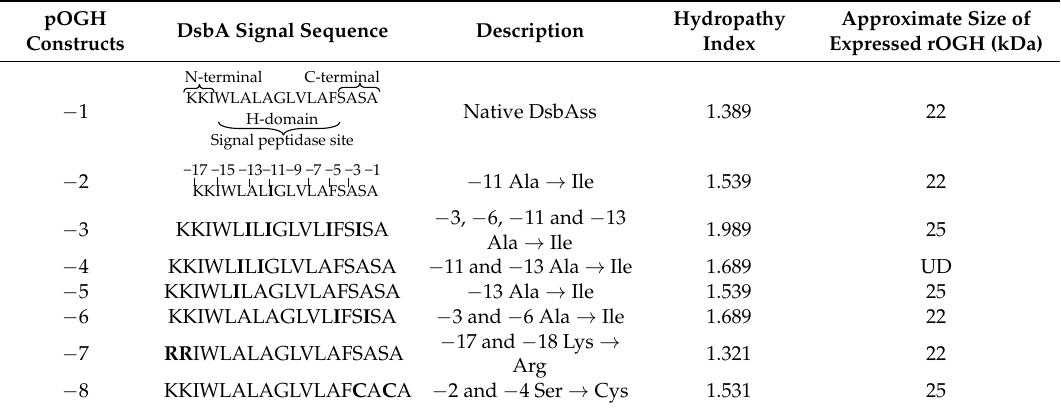
Table 2. Hydropathy indices of native and modified DsbA signal sequence (DsbAss) in pOGH constructs calculated using Swiss ExPASy ProtParam. The amino acid residues modified in native DsbAss are highlighted in bold.